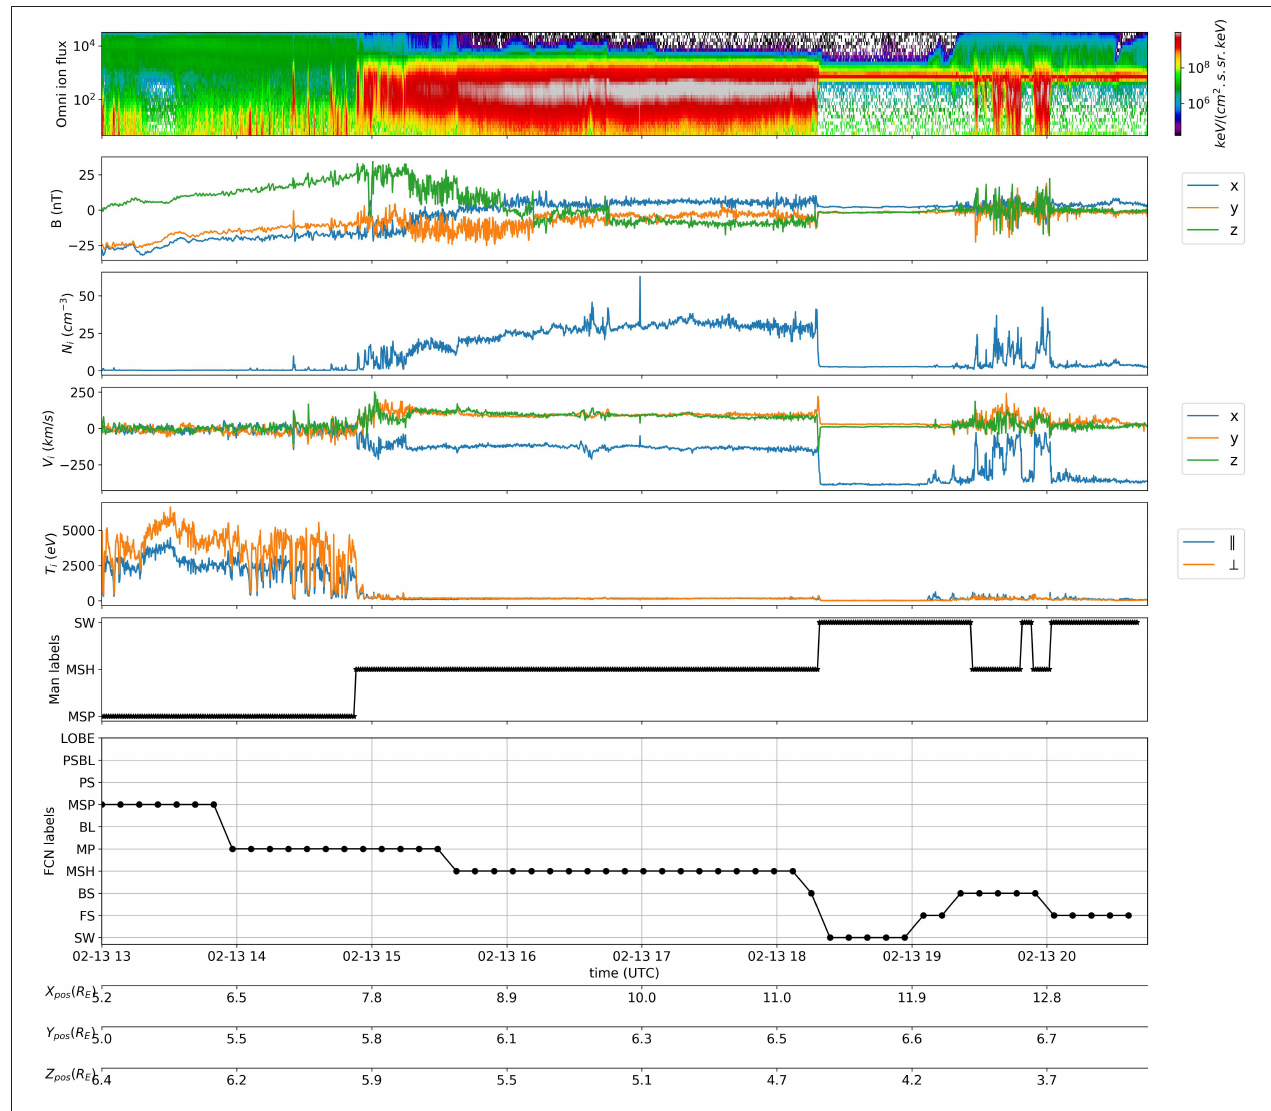
FIGURE 6 | Example of Cluster dayside classification.